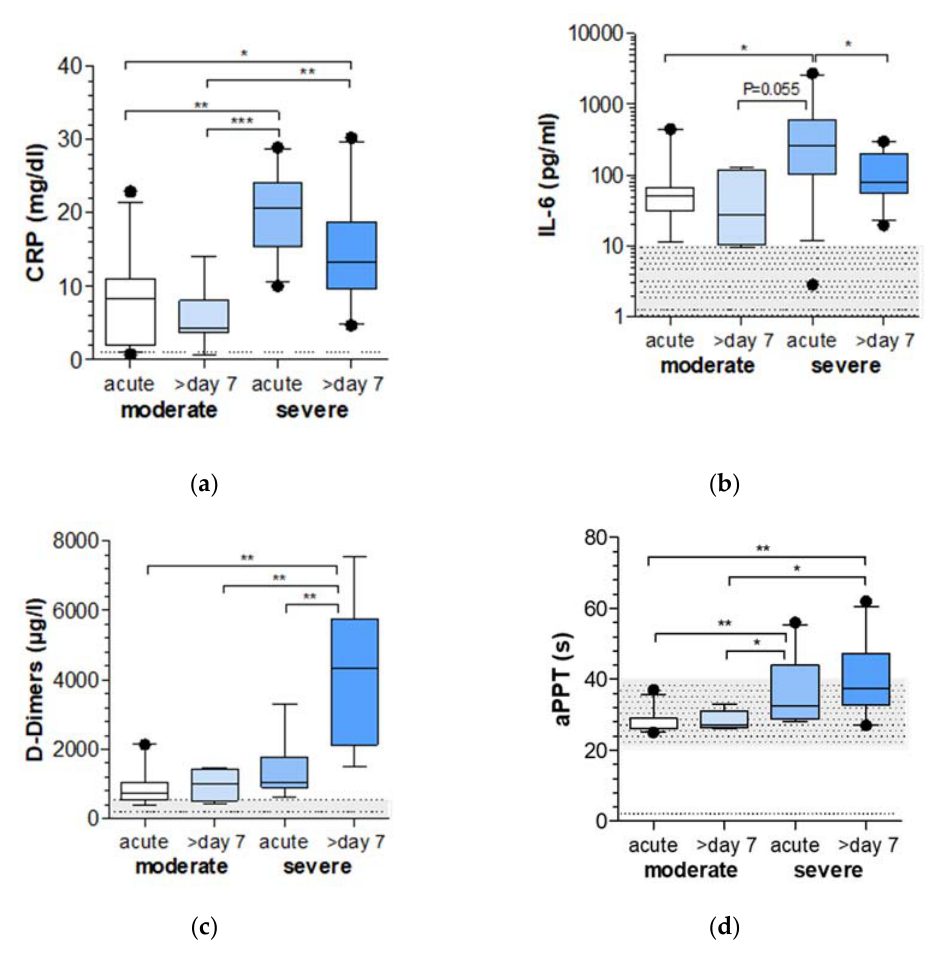
Figure 1. Inflammation and coagulation in COVID-19 patients with moderate and severe respiratory failure. Concentrations of inflammatory biomarkers such as ( a ) C-reactive protein (CRP) and ( b ) interleukin (IL)-6 and the biochemical biomarker ( c ) D-dimer and ( d ) activated partial thromboplastin time (aPTT) were analyzed in the peripheral blood of patients with moderate and severe respiratory failure induced by COVID-19 infection. Biomarkers were assessed during their stay at the infection ward or intensive care unit in the acute stage (day 0–3) and in the course of disease (>7 days). The gray areas indicate the standard ranges. * p < 0.05, ** p < 0.01, *** p < 0.001.